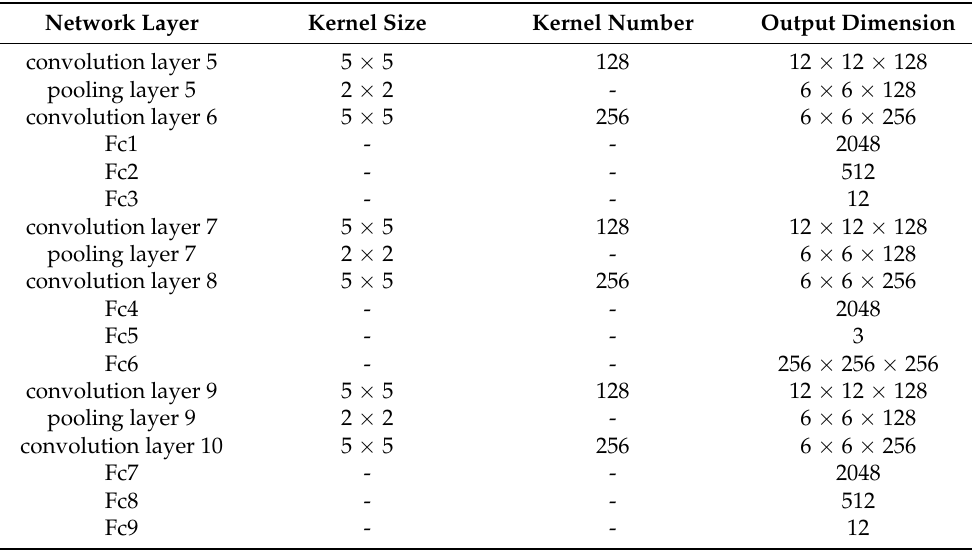
Table 6. The latter part of the MCNN parameters. Network Layer Kernel